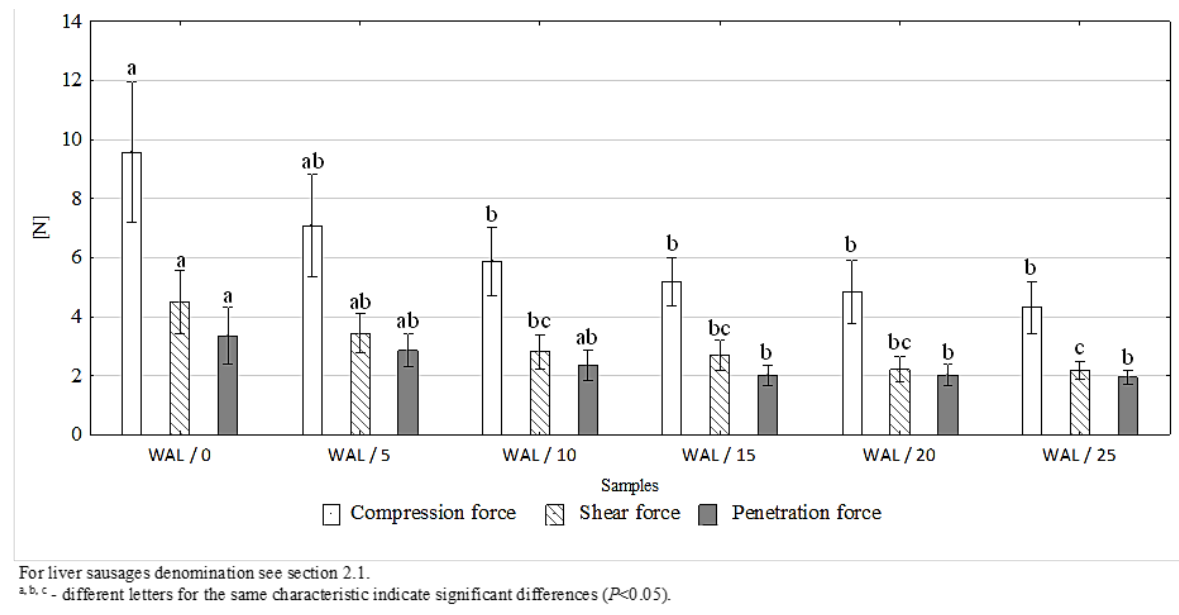
Figure 2. Compression, shear, and penetration force of the liver sausages, n = 4. Table 3. Spreadability, adhesiveness, and apparent viscosity of the liver sausages (mean value ± stan- dard deviation), n =